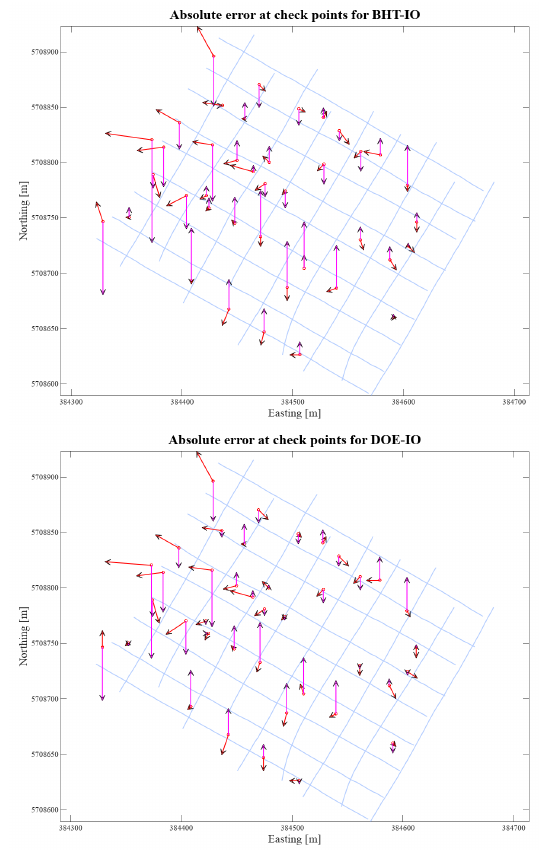
Figure 7. Direction of small systematic lateral differences (following the alternating flight pattern) of adjusted EO parameter The RMS at 40 check points are comparable (see Figure 8).